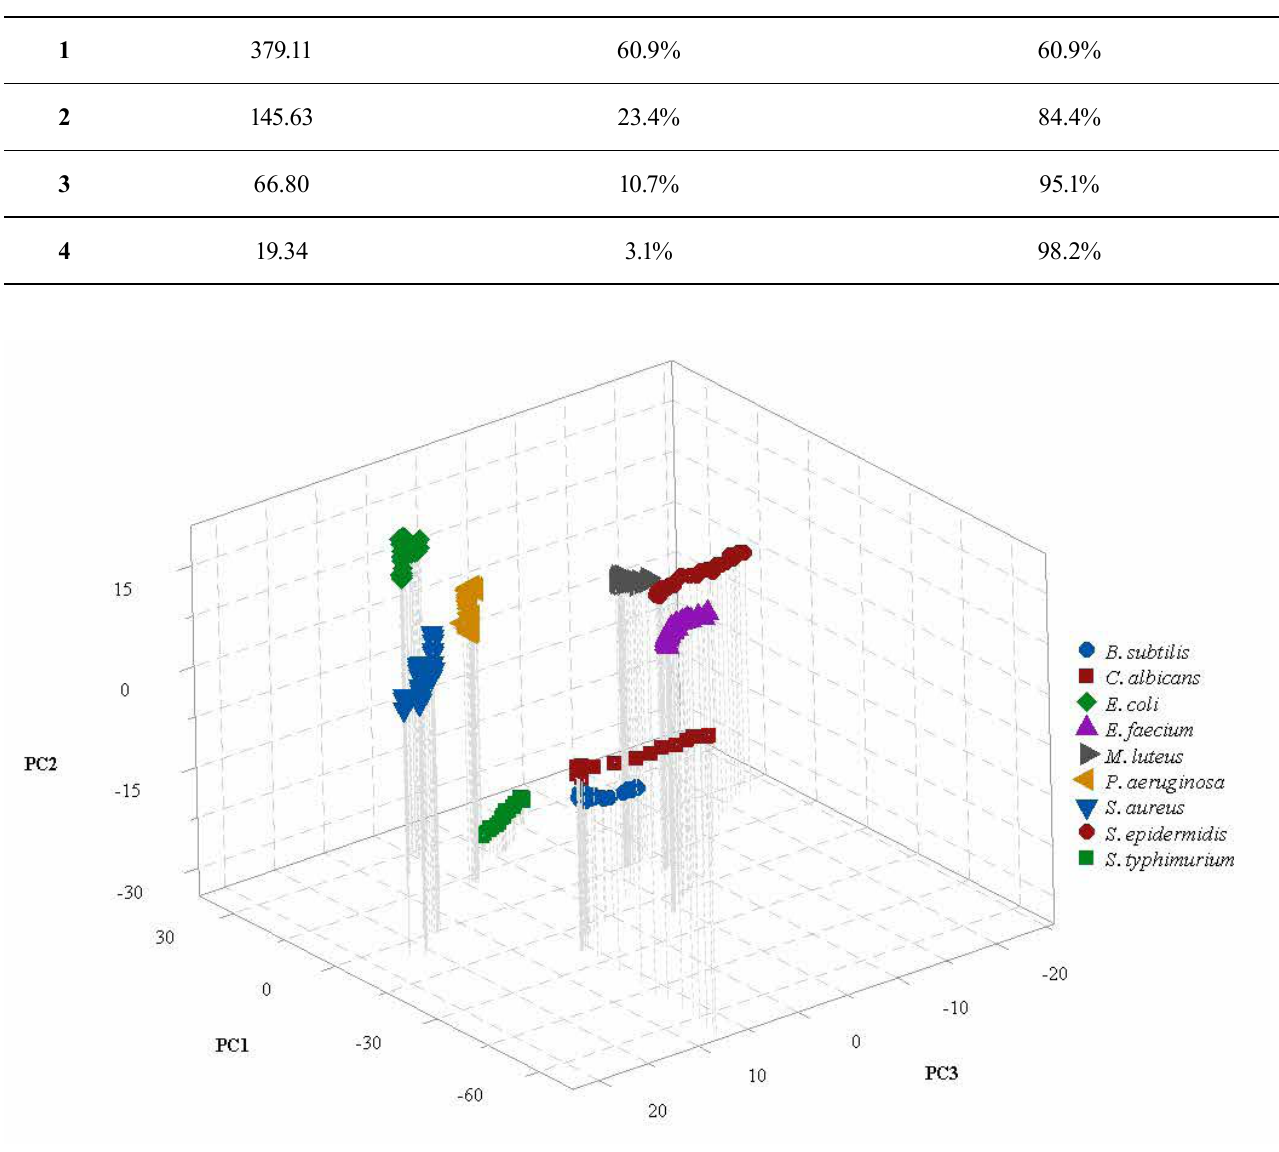
FIGURE 2 – PCA of Bacillus subtilis (ATCC 6633), Candida albicans (ATCC 10231), Enterococcus faecium (ATCC 8459), Escherichia coli (ATCC 8739), Micrococcus luteus (ATCC 10240), Pseudomonas aeruginosa (ATCC 9027), Salmonella typhimurium (ATCC 14028), Staphylococcus aureus (ATCC 6538), and Staphylococcus epidermidis (ATCC 12228) microbial